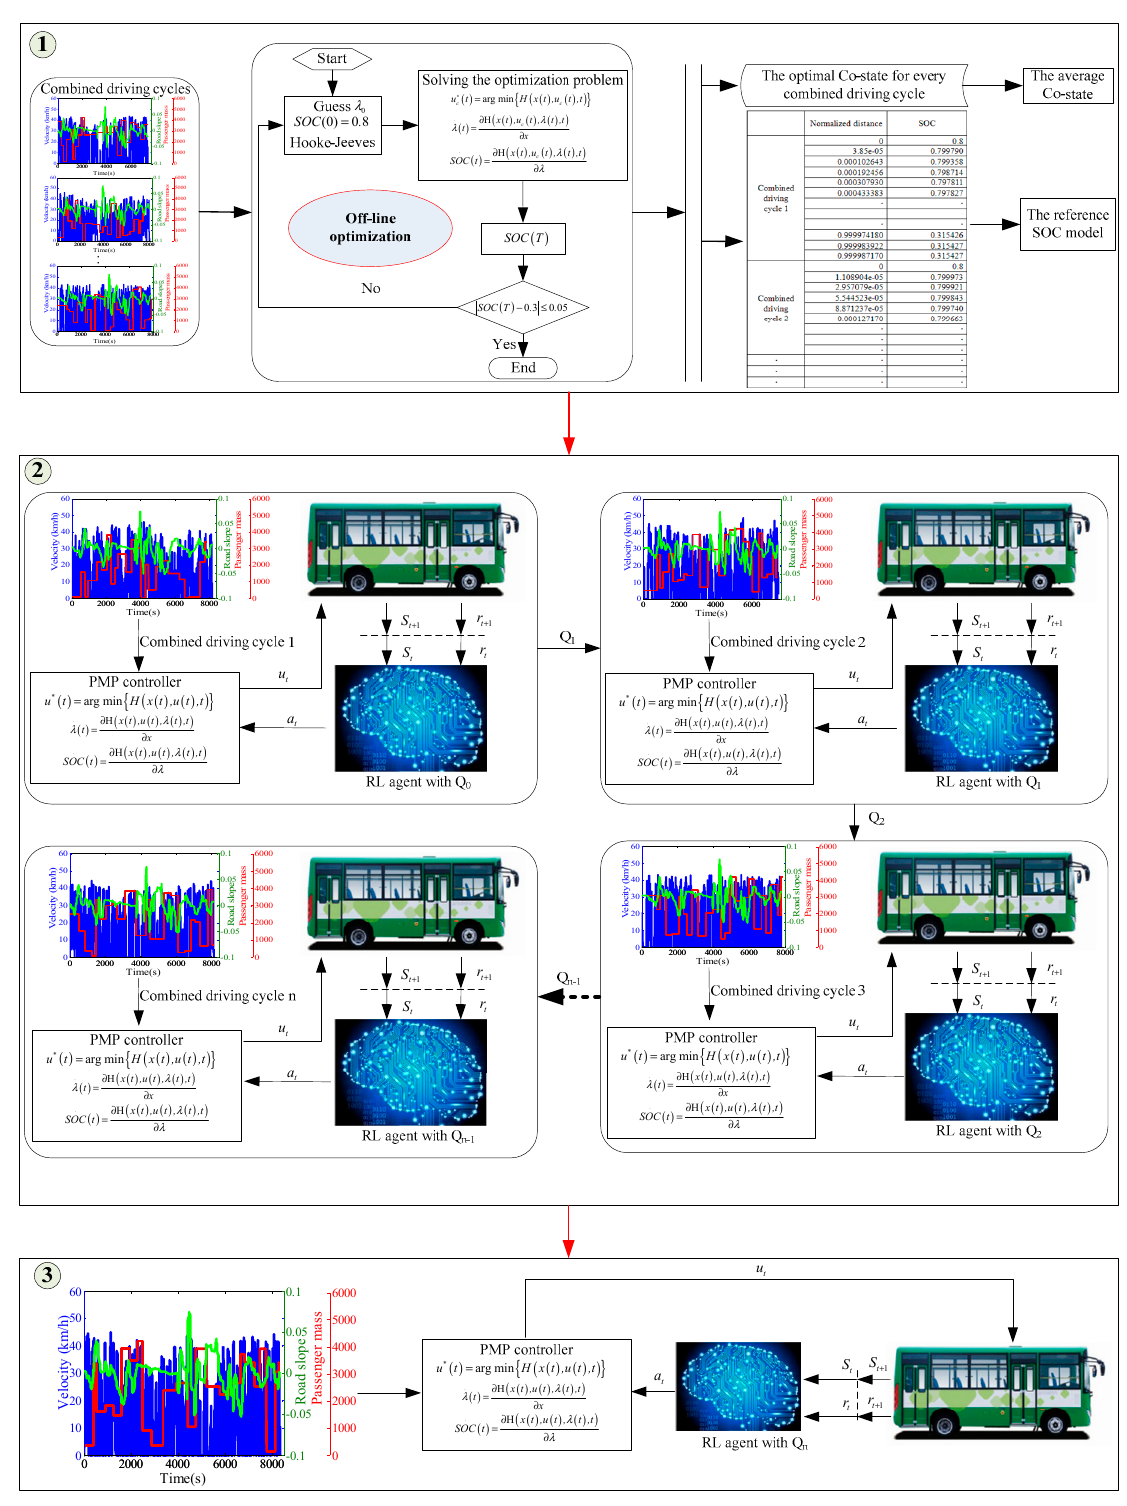
Figure 5. The QL-PMP algorithm (Q-learning and Pontryagin minimum principle (PMP)) algorithm. 3.1. The Combined Driving Cycle